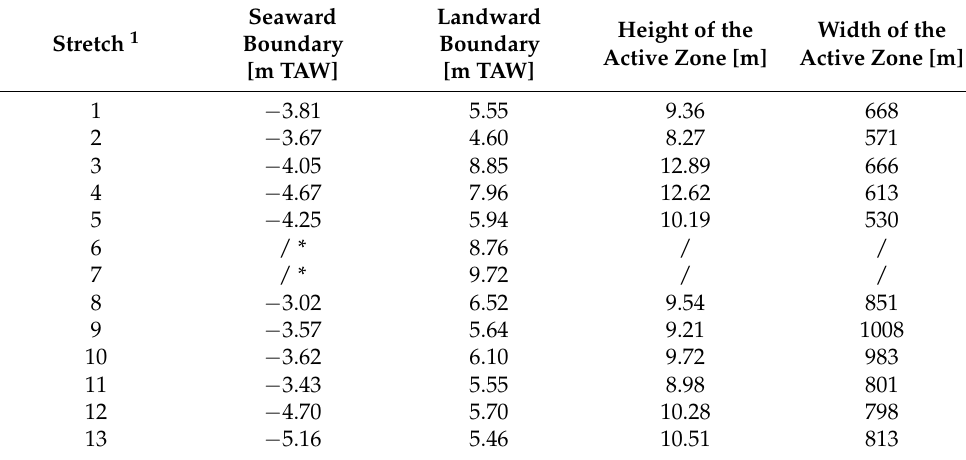
Table 1. Results from the analysis of the topobathymetric profiles.